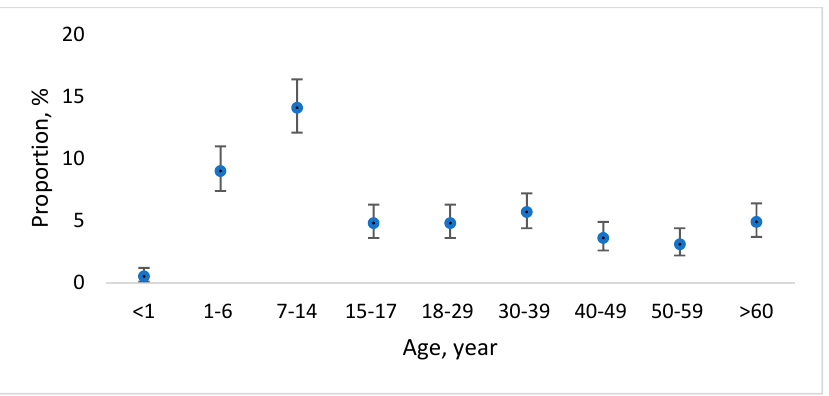
Figure 2. Proportion with 95% confidence interval of officially reported giardiasis cases per age group over the time period from 2000 to 2020 in Latvia.